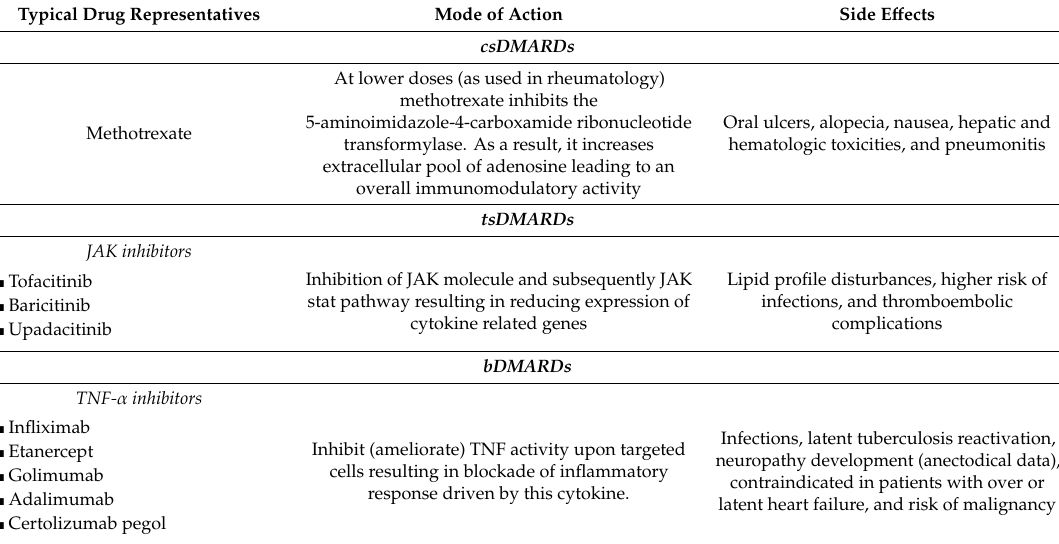
Table 1. Currently available classes of disease-modifying antirheumatic drugs